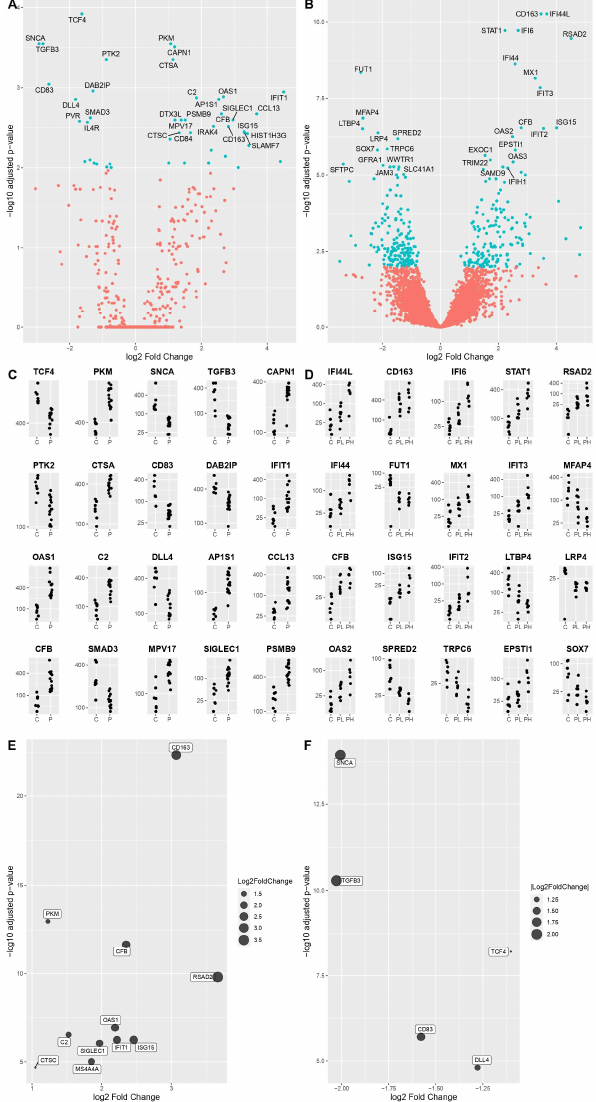
1 Figure 2. The volcano plots depict the DEGs in virus-vs.-control design according to nCounter ( A ) and RNA-Seq ( B ) analyses. Specifically, on the right part of the plot COVID-19 significantly overexpressed genes are highlighted in terms of statistical relevance, on the left the downregulated ones. Extreme positions on the x -axis mean higher log2 fold change. Panels ( C , D ) are showing the relative expression of the top 20 most deregulated genes, in the same design, in the nCounter and RNA-Seq methodologies, respectively (C = control, P = patient with virus in low and high load). Extended analysis of the commonly deregulated genes in the two methodologies is shown in panel ( E ) (most expressed) and ( F ) (least expressed), with the largest dots representing increasingly higher values of log2 fold